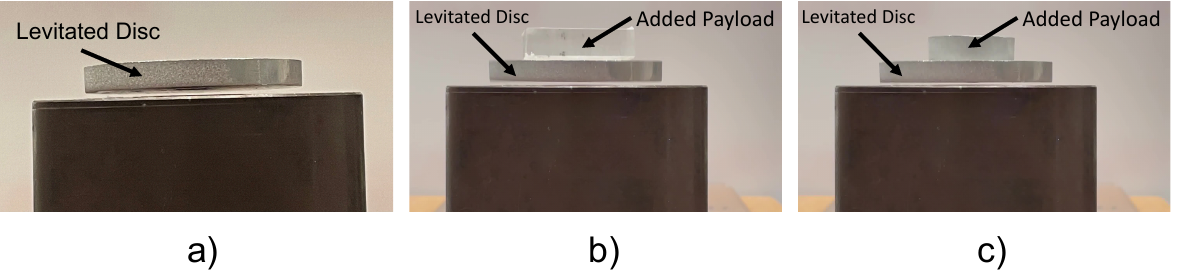
Figure 13. Experiment with additional payloads to highlight stable levitation with added mass as expected within the AM environment. ( a ) Free levitation of aluminum disc. ( b ) Added payload: 4.4 g (17% of initial disc). ( c ) Added payload: 15.2 g (59% of initial disc).